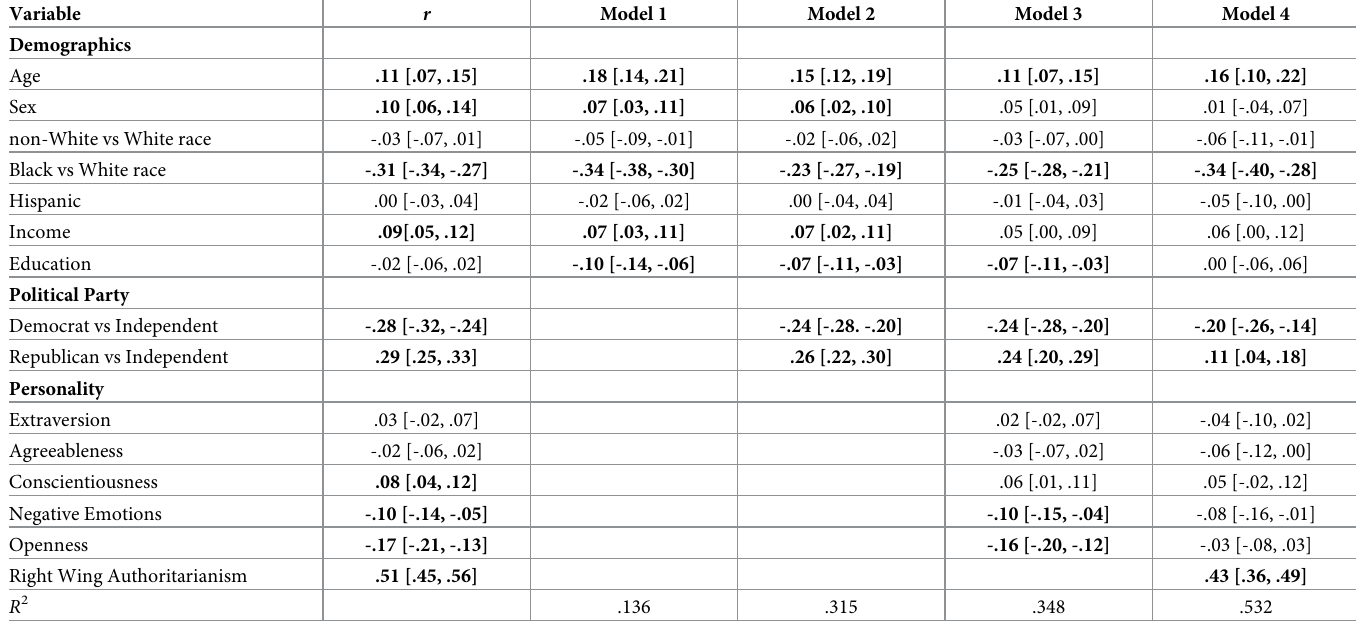
Table 3. Correlations, standardized regression coefficients, and 95% confidence intervals for associations between pro-police attitudes random intercept factor and time-invariant